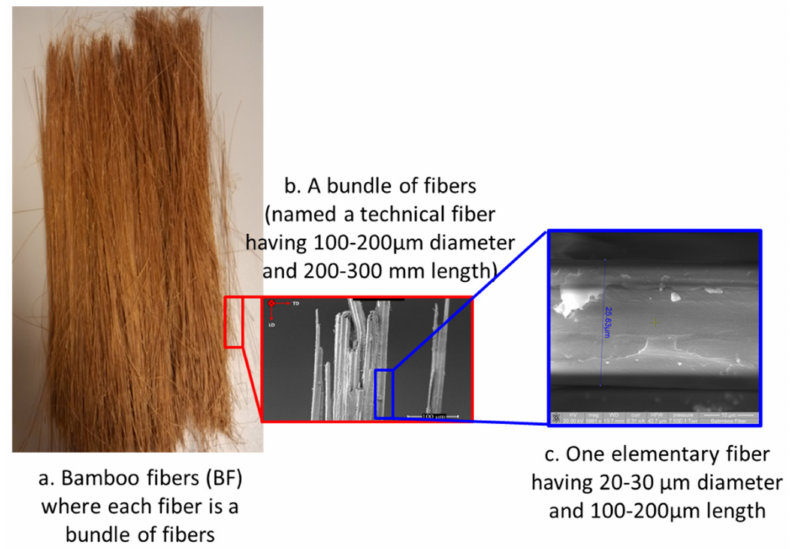
Figure 1. Illustration of bamboo fibers extracted using U.S. Patent No.10184215, optical microscope image of a bundle of fibers and scanning electronic microscopy of one elementary